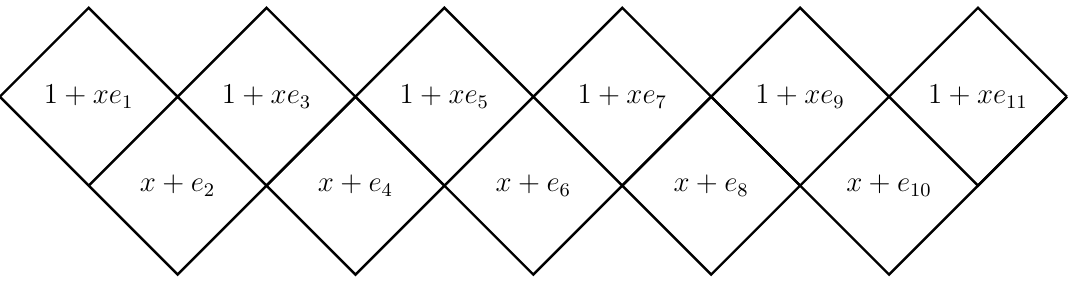
and with defects ω defined in (3.23). i 2